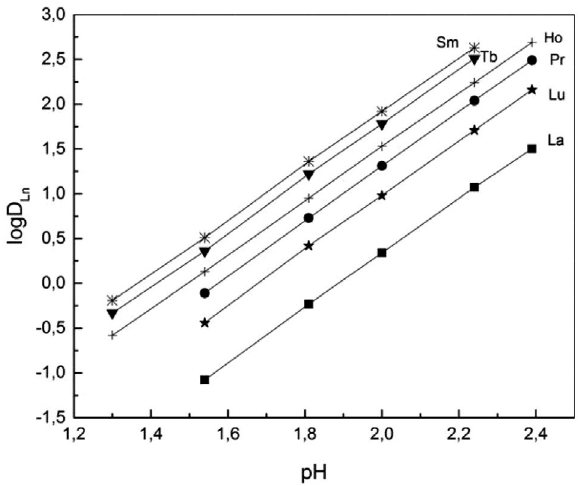
Figure 3. The effect of pH on the extraction of Ln(III) with the mix- ture of 0.001 M compound III and 0.01 M HP in